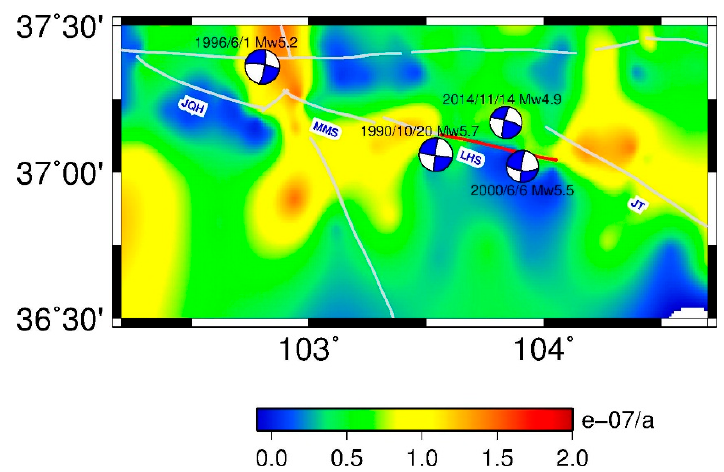
Figure 8. The horizontal strain rate (the second invariant of the strain rate tensor) distribution in Laohu Shan fault zone and its surrounding area. The grey lines indicate the Haiyuan fault system (JQH: Jing Qiang He, MMS: Maomao Shan, LHS: Laohu Shan, JT: Jing Tai). The red line indicates the creeping segment identified by Jolivet et al. [17], and GCMT focal mechanisms are given for four moderate earthquakes occurred in this region in the past 30